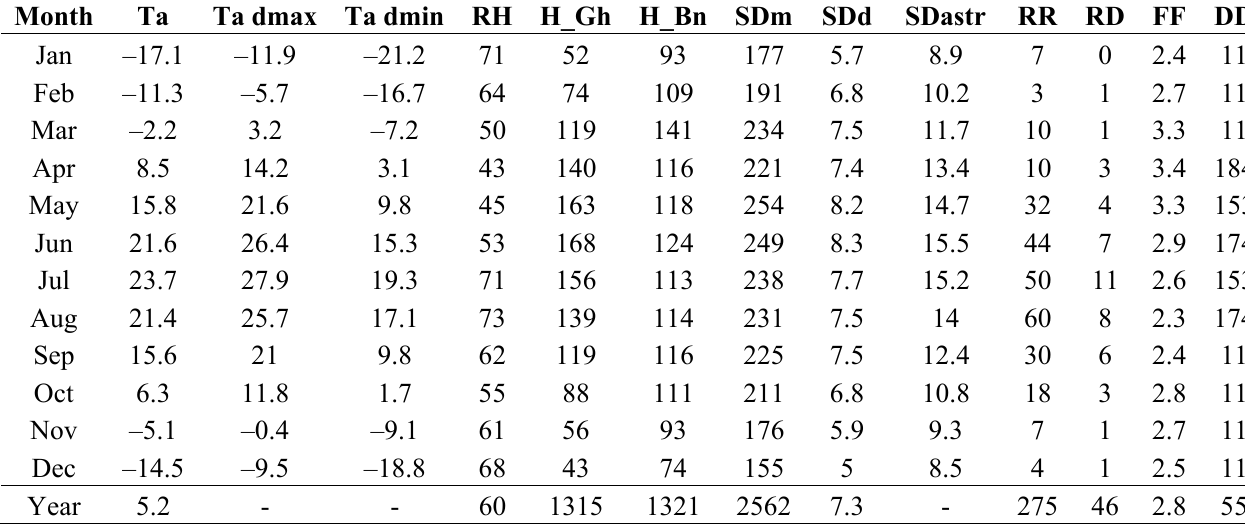
Table 1. Table of Harbin (44.5°N) climate data summary (MeteonormV6.1 data period: